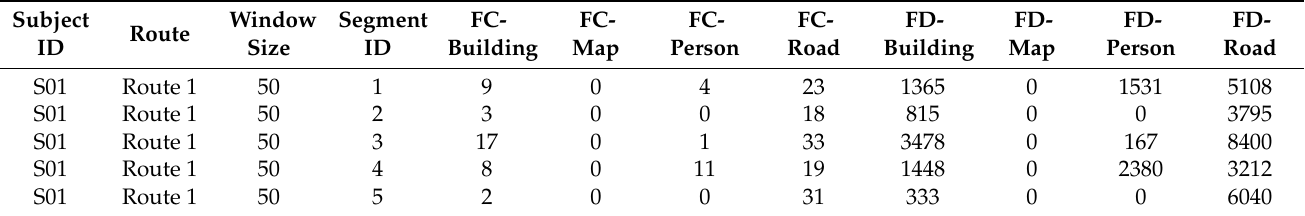
Figure 4. Semantic segmentation of the videos and fixation annotation. Table 4. Examples of fixation semantic features (before adjustment). FC: fixation count. FD: fixation duration.